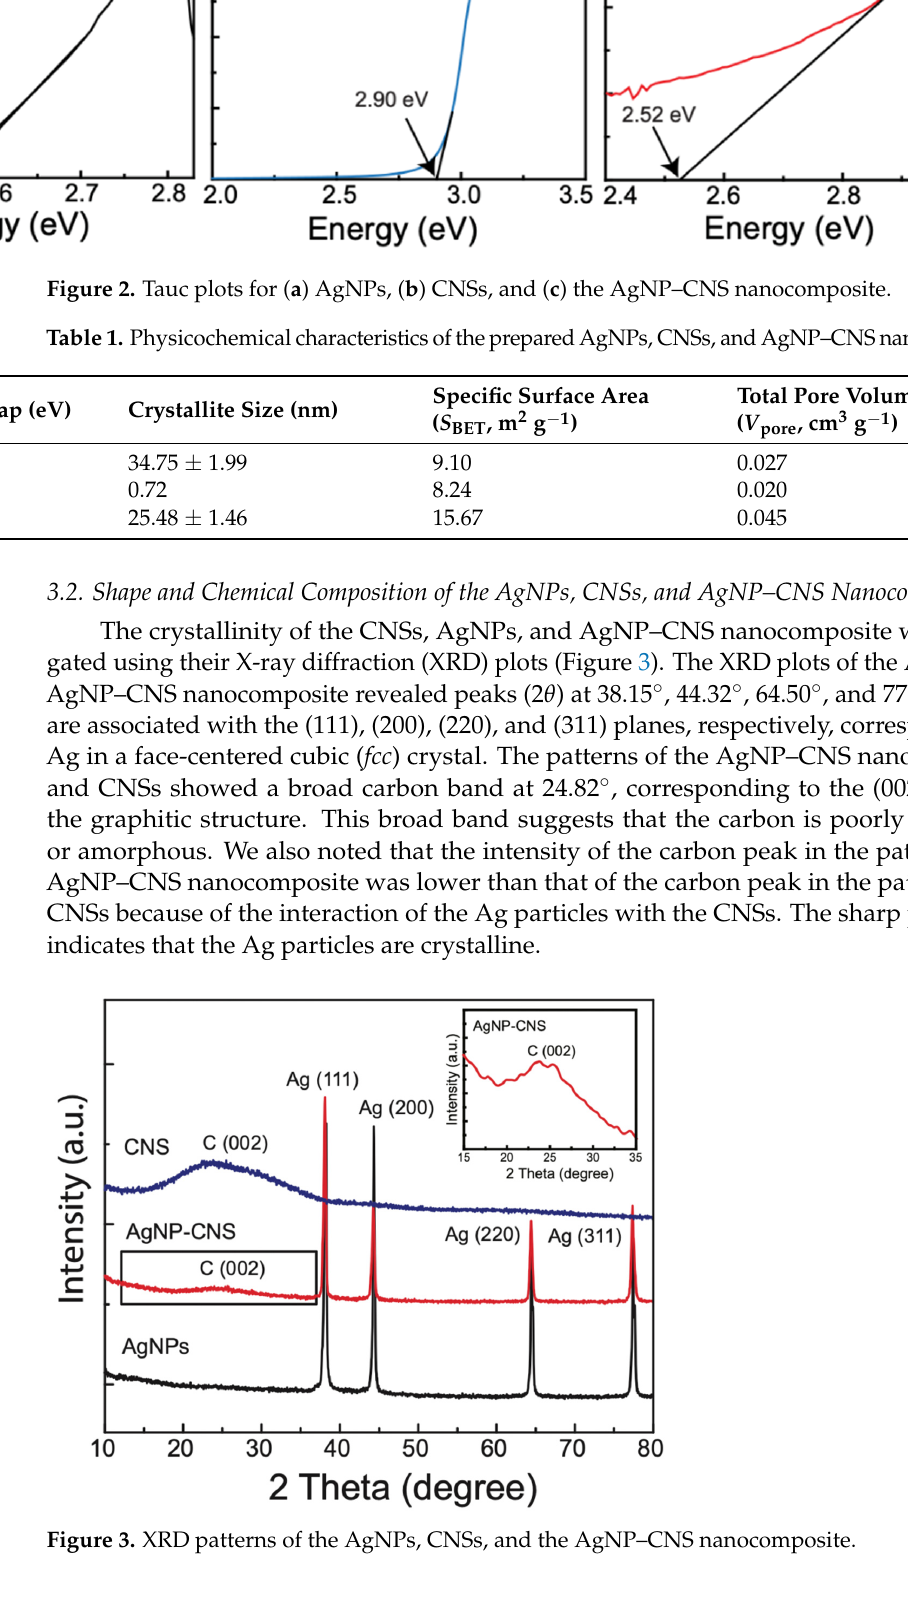
Figure 3. XRD patterns of the AgNPs, CNSs, and the AgNP–CNS nanocomposite.